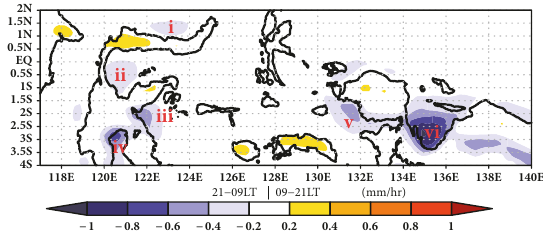
Figure 4: Different rainfall day times–nighttime around IMC. Minus value describes the rainfall mostly at nighttime over concave coastline, i.e., (i) Manado Bay, (ii) Tomini Bay, (iii) Tolo Bay, (iv) Bone Bay, (v) Berau Bay, and (vi) Cenderawasih